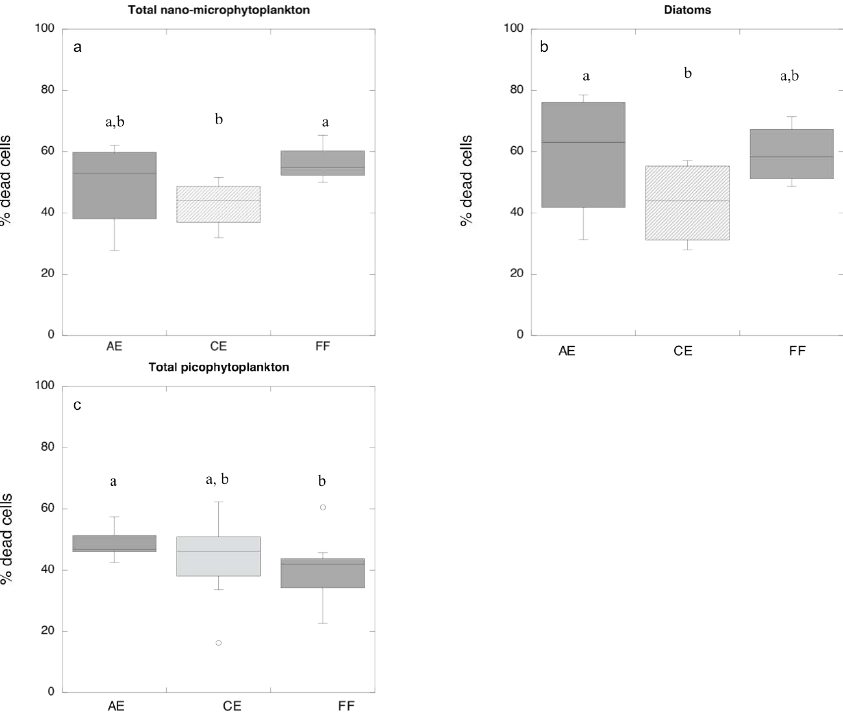
Fig. 7. Distribution of the viability (percentage of living cells) of (a) total nano- and microphytoplankton, (b) diatoms and (c) total picoplank- ton populations within AE, CE and FF stations. Boxes show the lower and upper quartiles, median, minimum and maximum values, and outliers (open circles). Boxes connected by same letter are not significantly different ( p < 0.05).